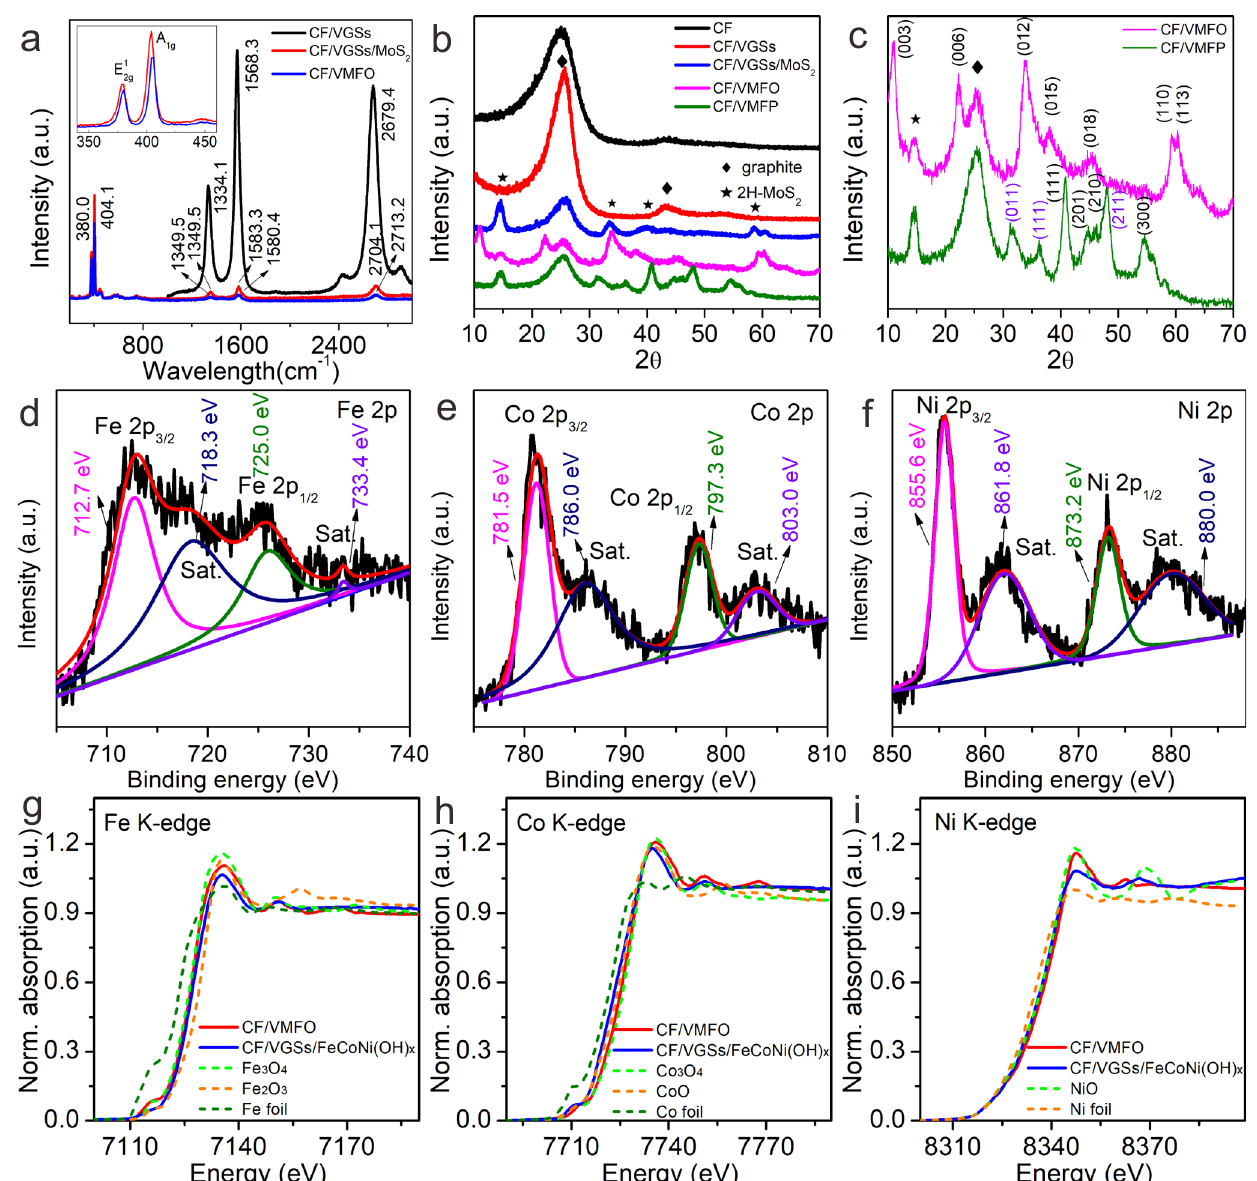
Fig. 4 Raman spectra, XRD patterns, XPS spectra, and XANES spectra of different samples. a Raman spectra of CF/VGSs, CF/VGSs/MoS 2 , and CF/ VMFO. b XRD patterns of different samples. c Magni fi ed XRD patterns of CF/VMFO and CF/VMFP. d – f XPS spectra of Fe 2p ( d ), Co 2p ( e ), and Ni 2p ( f ) for CF/VMFO. g – i Normalized Fe ( g ), Co ( h ), and Ni ( i ) K-edge XANES and spectra of CF/VMFO, CF/VGSs/FeCoNi(OH) x , and standard samples. The inset of a is the magni fi ed Raman spectra of CF/VGSs/MoS 2 and